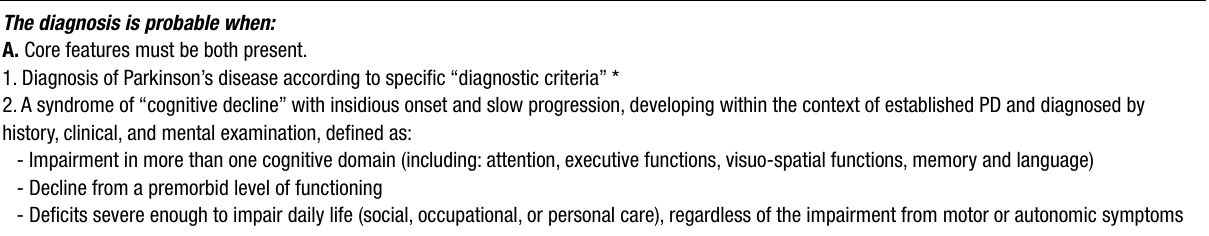
Table 1. Criteria for the diagnosis of probable and possible Parkinson’s disease dementia 1